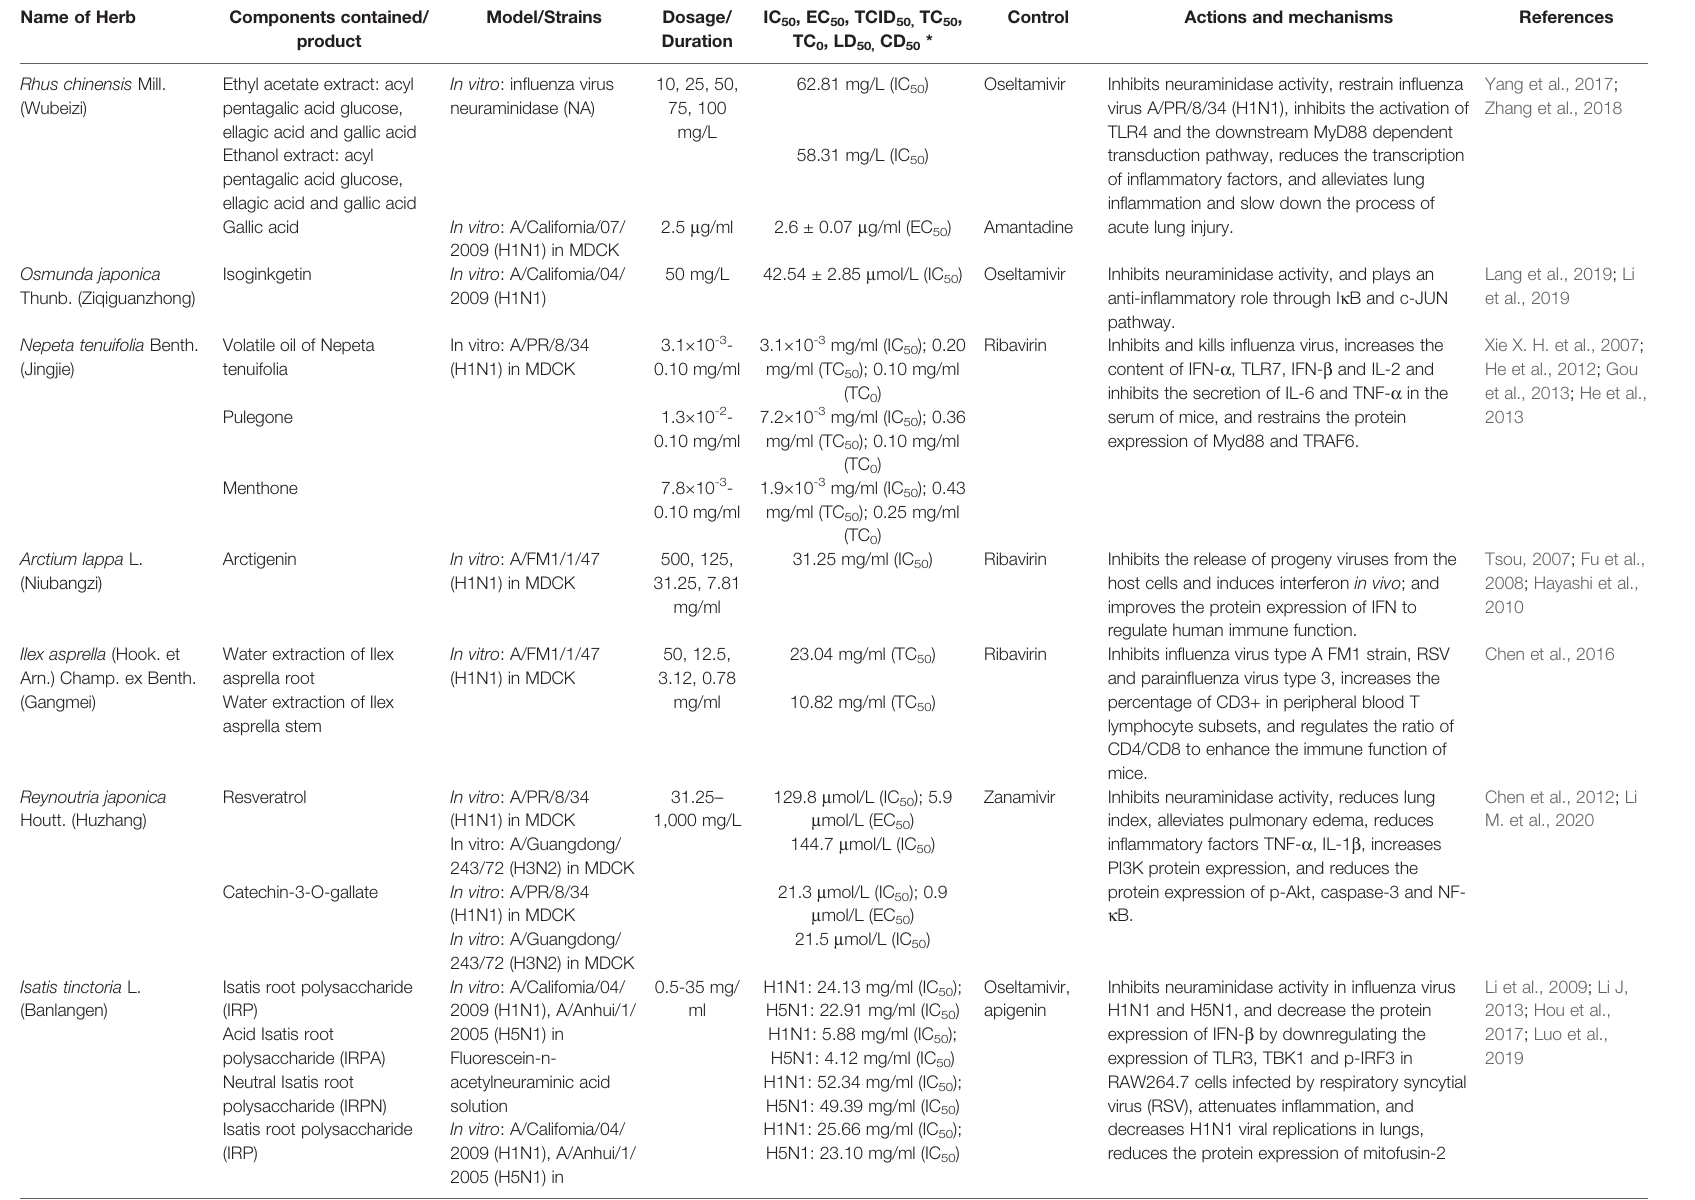
TABLE 1 | Effects and mechanisms of single Chinese medicine and its components on antiviral pneumonia. Name of